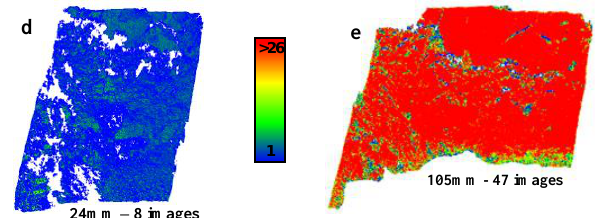
Figure 6. Point-cloud density for the different models used in the study